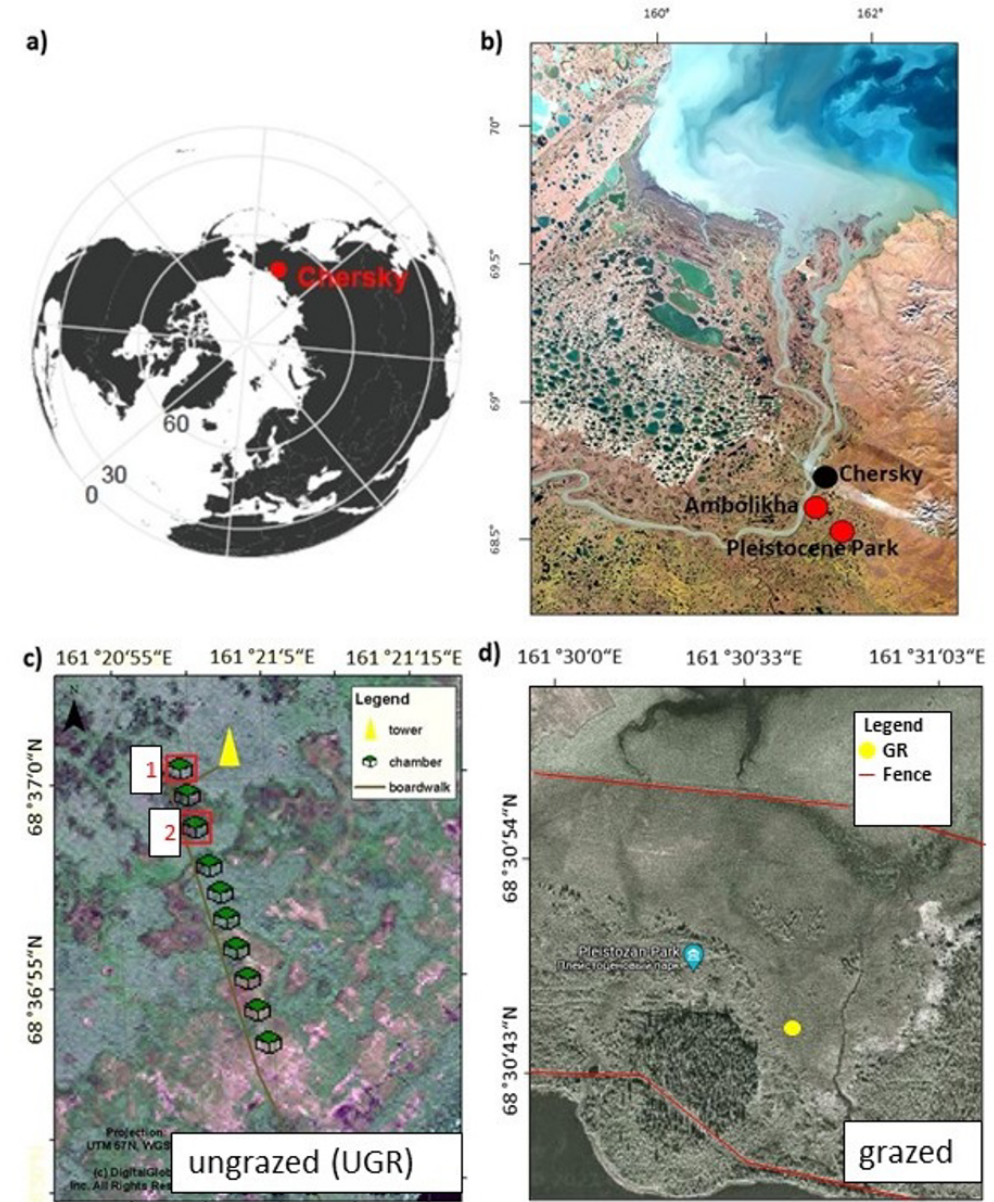
Figure A1. Location of study sites. (a) Circum-polar map showing the location of the study site near Chersky in northeast Siberia. (b) Landsat composite image of the study region close to Chersky. (c) Aerial photograph of the Ambolikha site; the location of the meteorological tower and eddy-covariance system and chamber plots are indicated. Plot numbers 1 (UGR-1) and 2 (UGR-2), which denote sites used in this study, are framed in red boxes. (d) Location of the GR observation sites inside Pleistocene Park. The area between the fences (red) is the core area with the highest grazing